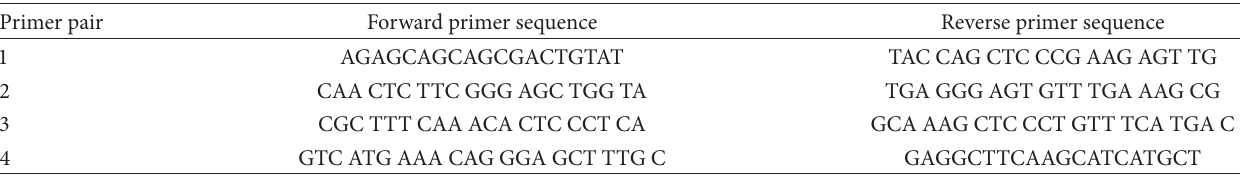
Table 1: Scanning qPCR primer pair sequences for PGC1 𝛼